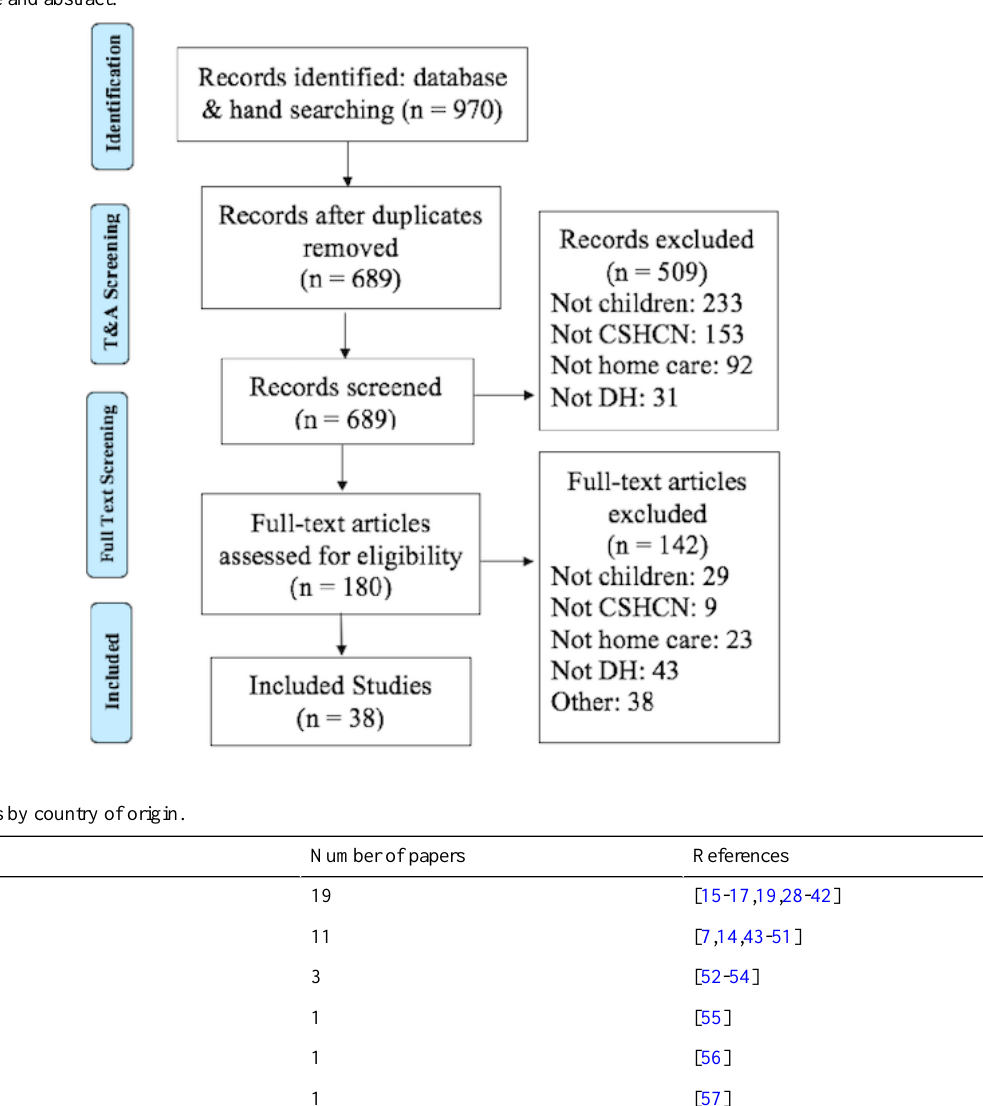
Figure 1. Preferred Reporting Items for Systematic Reviews and Meta-Analyses flow diagram. CSHCN: children with special health care needs; DH: digital health; T&A: title and abstract.